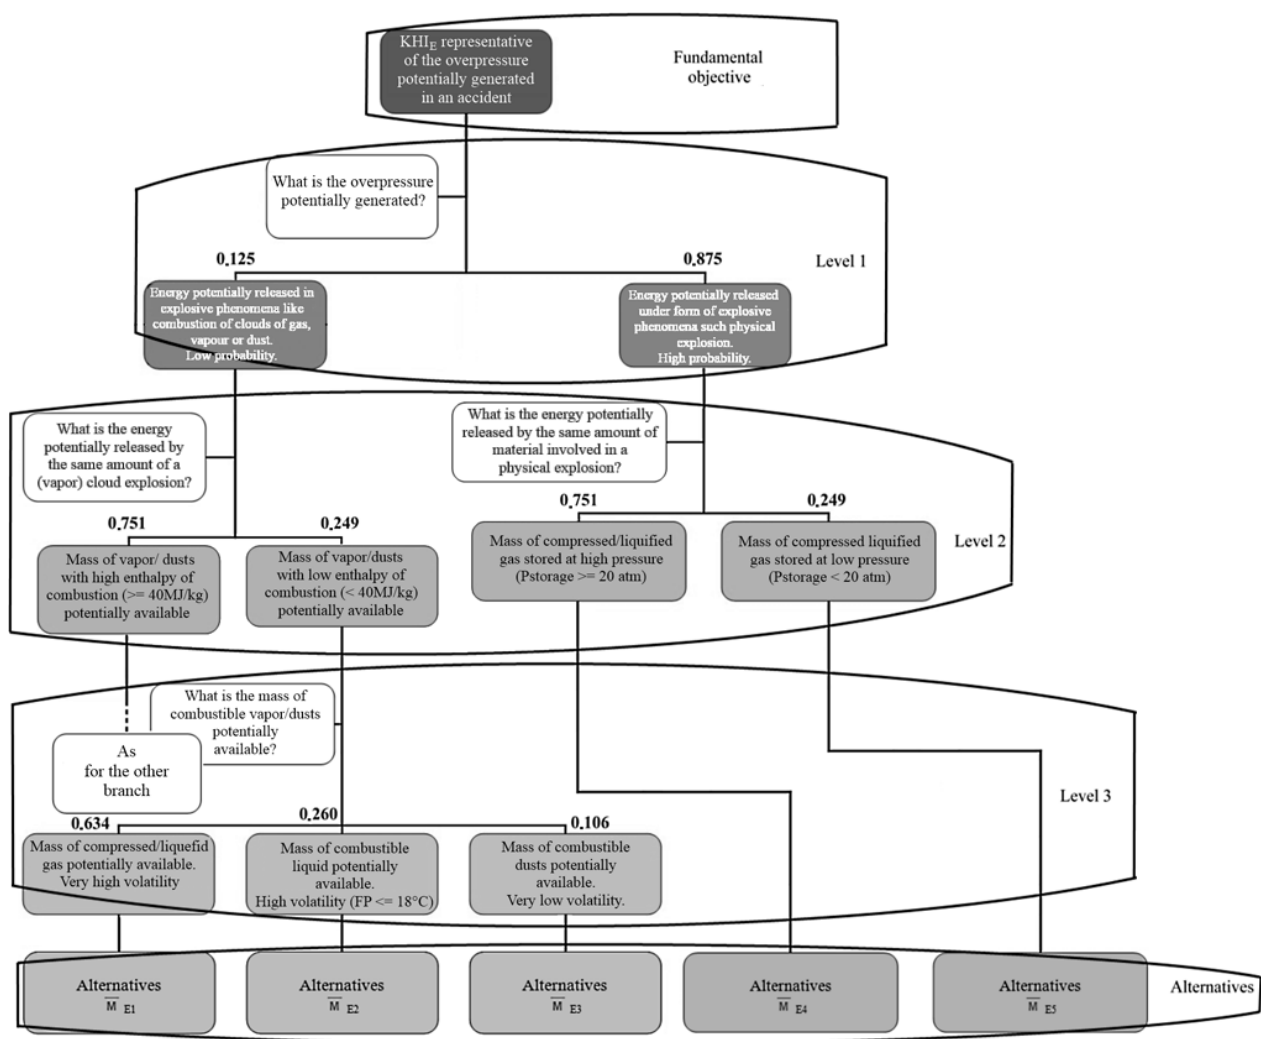
Fig. 3. Hierarchy used for flood-related Na-Tech qualitative risk analysis in case of an explosion. The weights assigned are shown along the different branches, while the related question to be answered is located above each